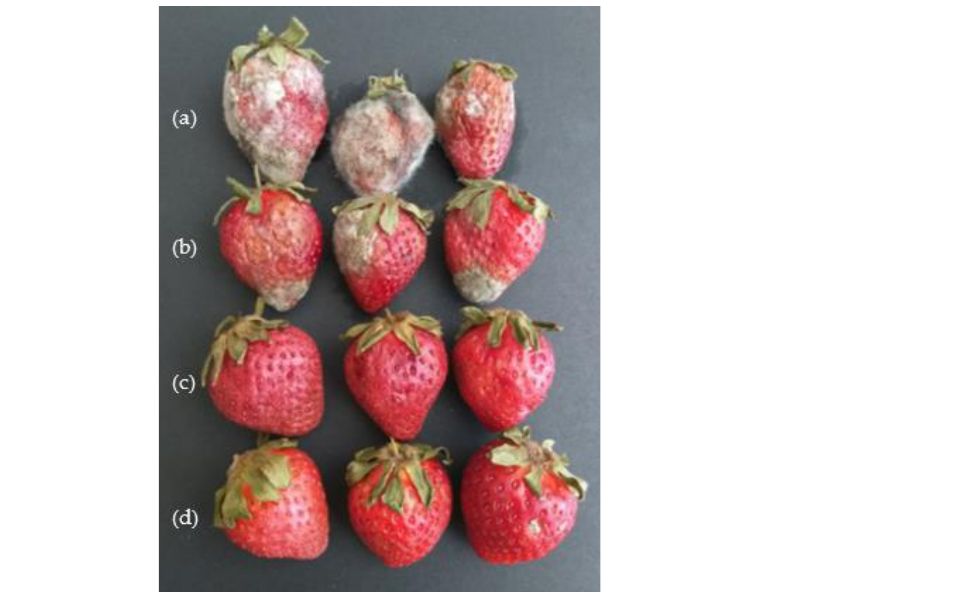
Figure 6. Decay by gray mold disease of strawberry fruits 10 days after artificial inoculation: ( a ) untreated fruits; fruits immersed in a COS − U. tomentosa solution at different concentrations, viz., ( b )